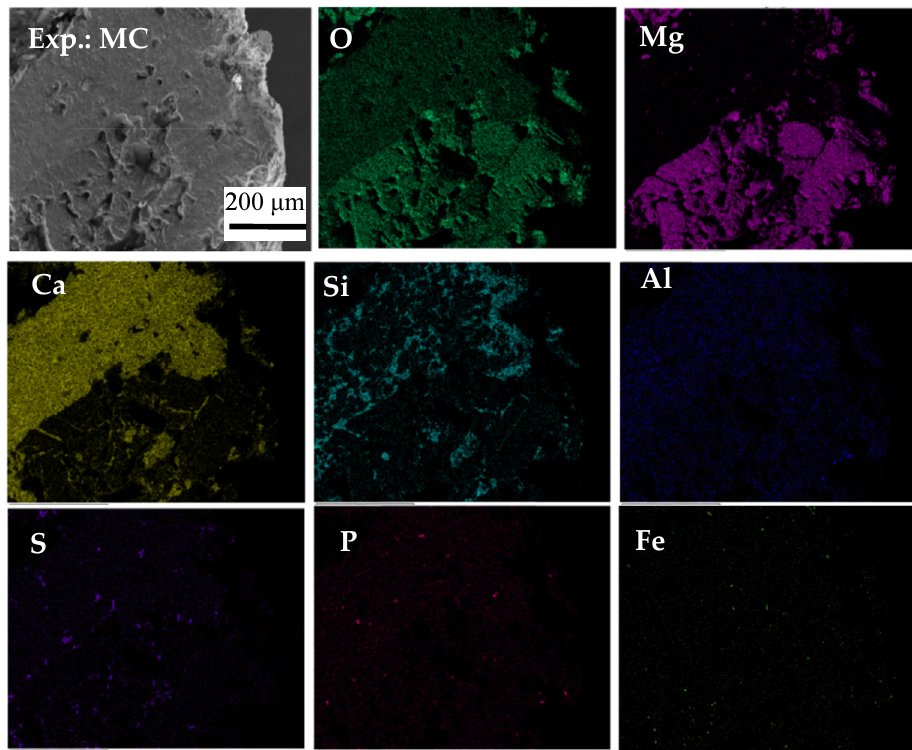
Figure 11: Element mapping results of MgO – CaO crucible.